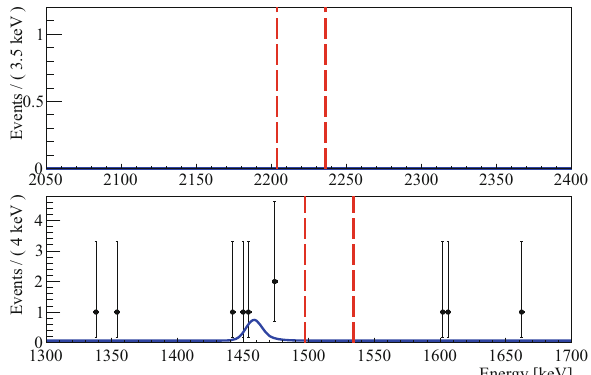
Fig. 4 Energy spectra of E main corresponding to signatures A (top) and B (bottom) with an exposure of 2.24 × 10 25 emitters · yr. The red vertical bars indicate a ± 2 σ region centered around E main (Table 1). The best fit result is shown in blue. In the bottom panel we include also a peaking background to model the excess of events at the energy of 40